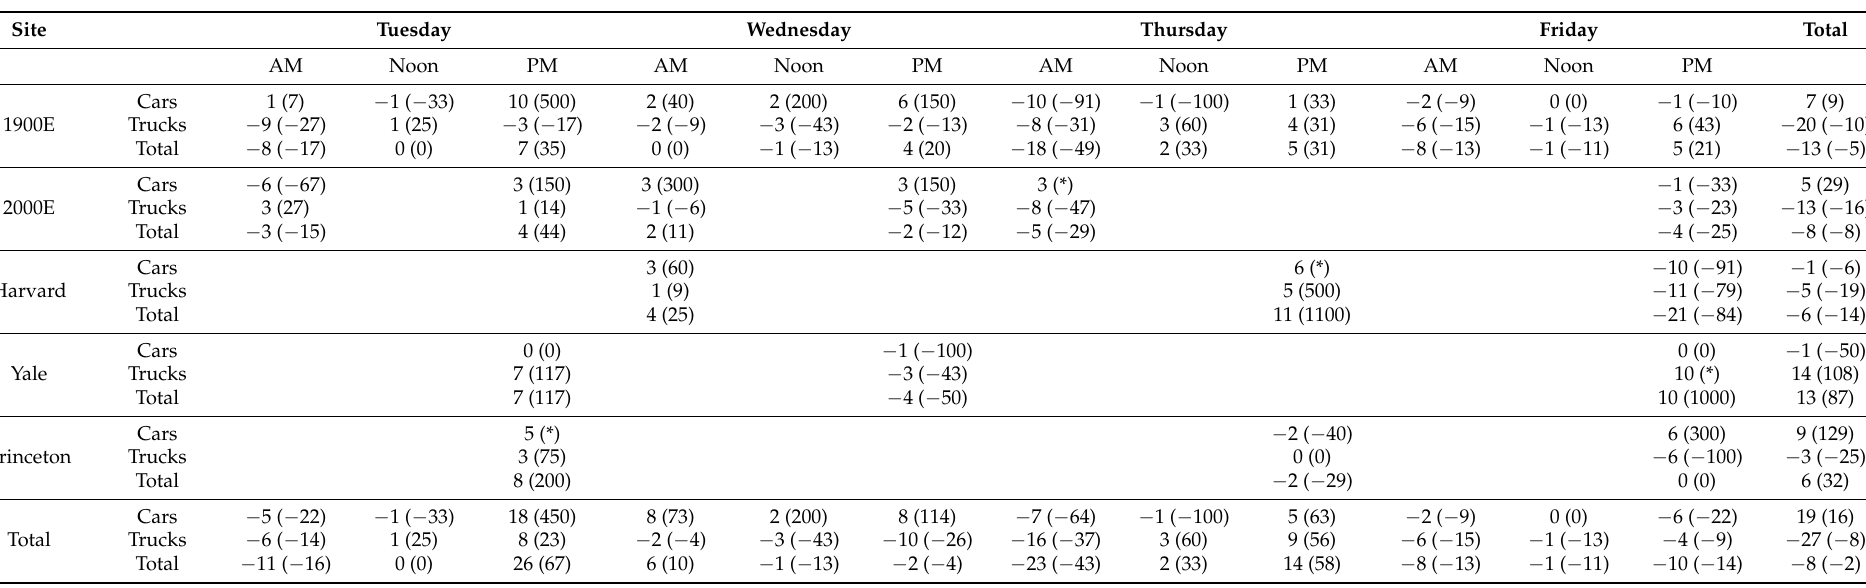
Table 5. Total vehicle counts difference (percent difference) between post-intervention week: 18–21 February 2020 and pre-intervention week: 17–20 September 2019. * denotes that there were no vehicles in the pre-intervention period and would have resulted in division by